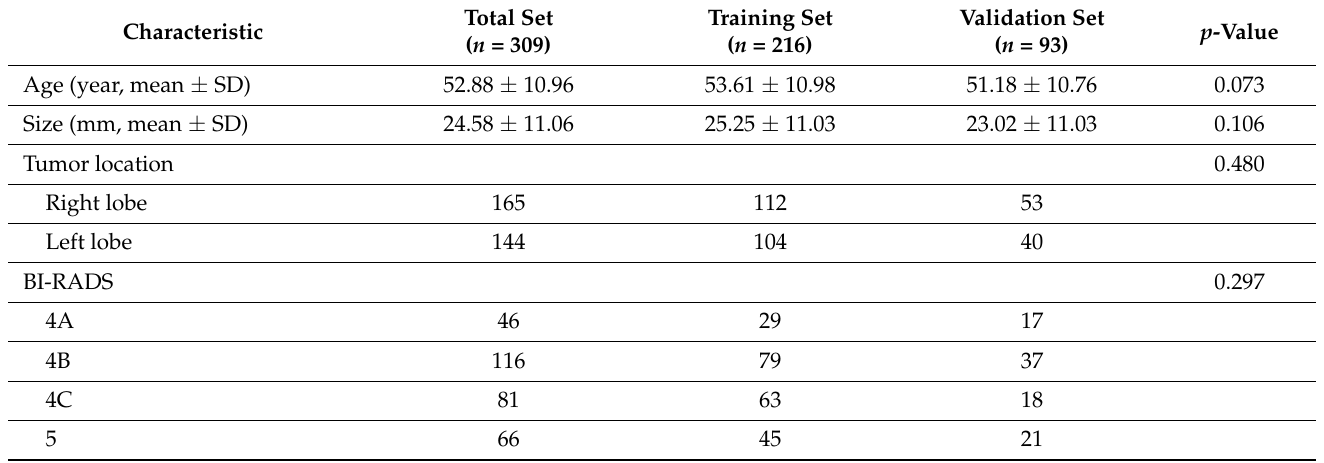
Table 1. The baseline characteristics of the enrolled patients in the training and validation